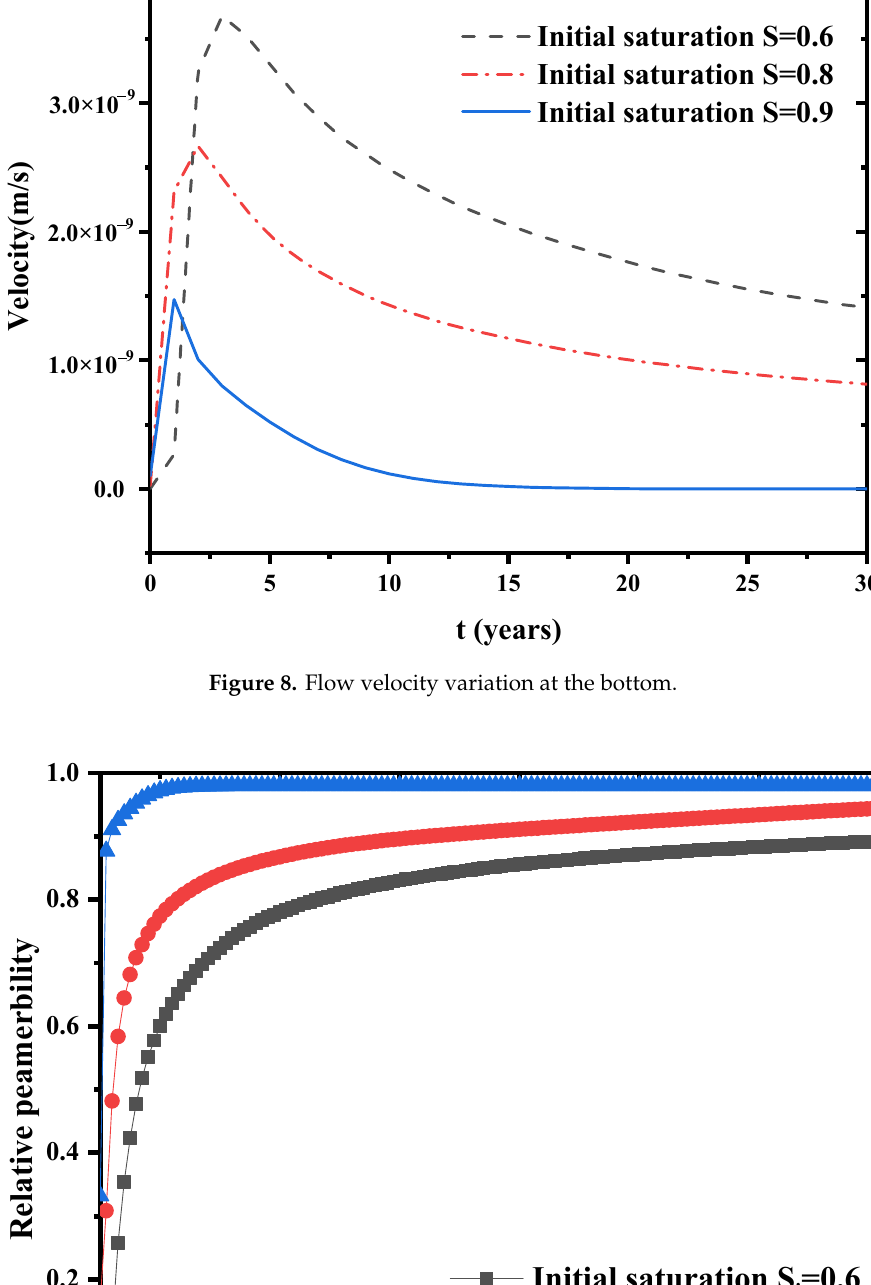
S i =0.8 Figure 10. Variation of cumulative pollutant emissions at different initial saturations.